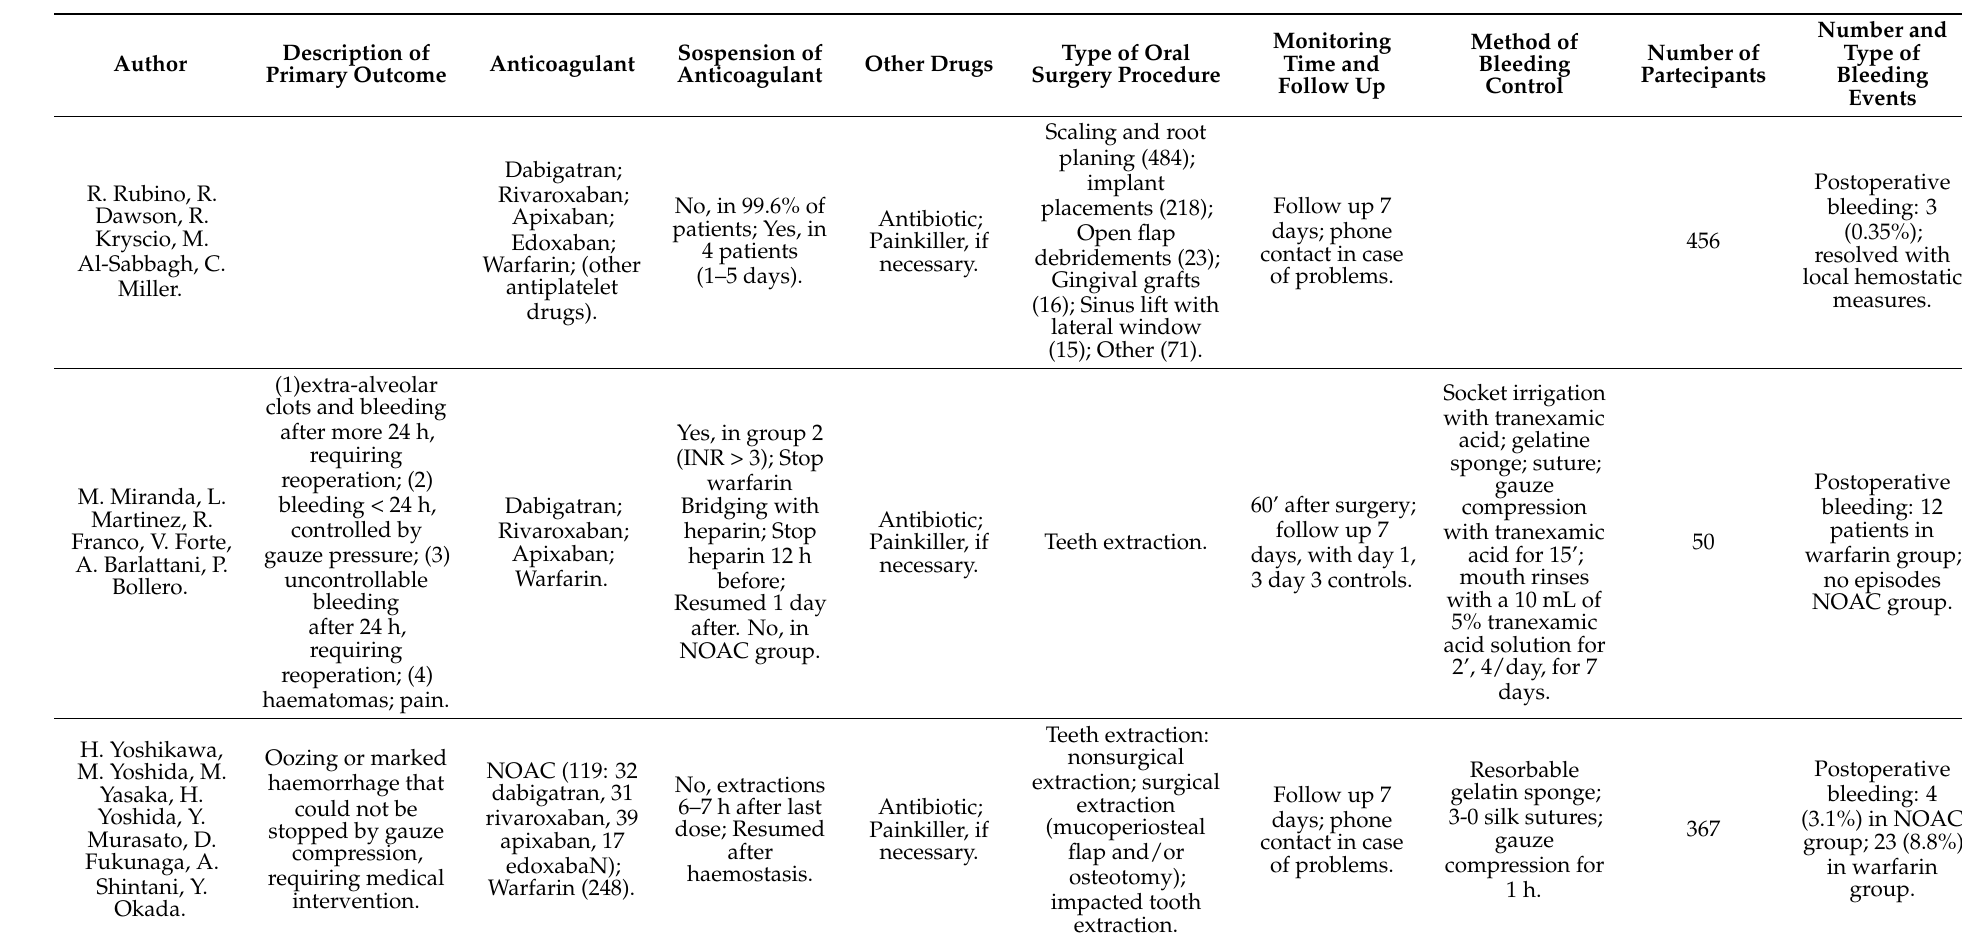
Table 3. Studies considering both VKAs and